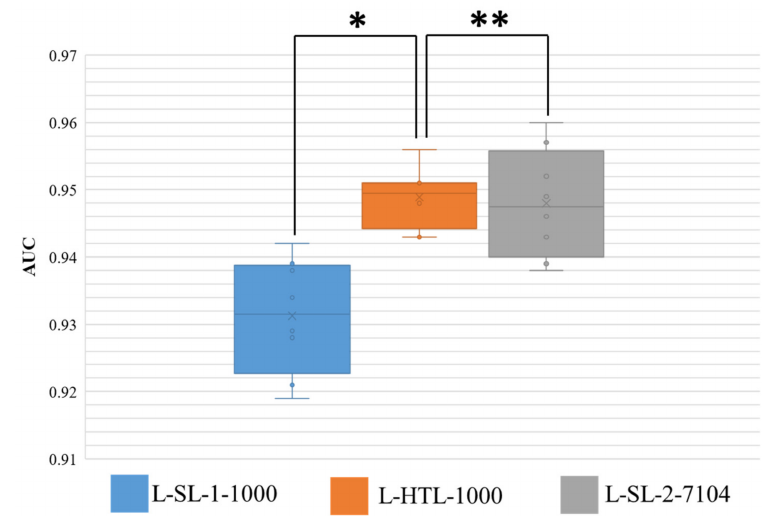
Figure 4. This figure displays the distribution of area under the curve (AUC) for the three models on Dataset-SLN. The ** symbol indicates no significant statistical difference, while * indicates that there is a statistical difference. The boxes represent the upper and lower quartile values, and the whiskers indicate the minimum and maximum values. The horizontal bar within the box denotes the median, while the cross denotes the mean. The circles represent data points, while the scatter dots indicate outliers.